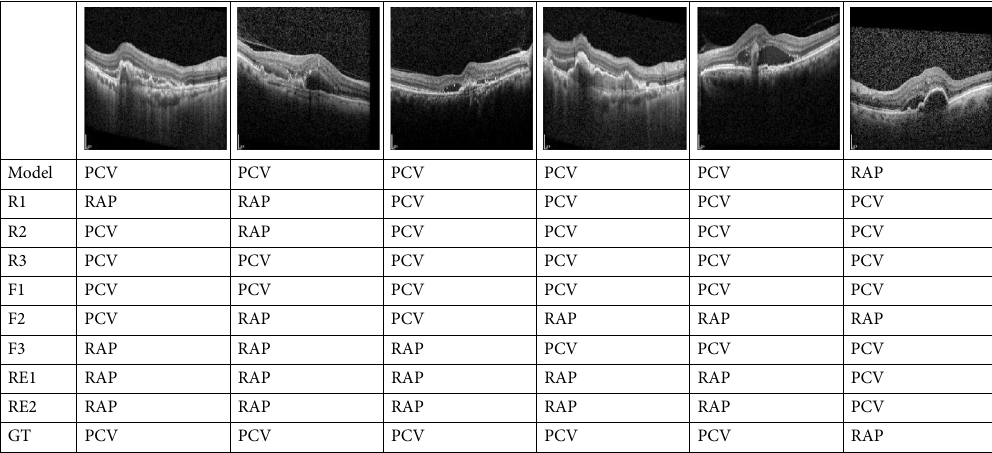
Table 3. Examples of decisions made by the model and 8 human experts. These 6 images are the cases, which our model classified correctly even though two retina experts classified incorrectly. PCV, polypoidal choroidal vasculopathy; RAP, retinal angiomatous proliferation; R1, R3 and R4 denote ophthalmology residents with 1 year, 3 years, and 4 years of experience, respectively. F1, F2, and F3 denote retina fellows with 2 years of experience. RE1 and RE2 refers to retina experts with more than 10 years of experience as retina experts. GT denotes the ground